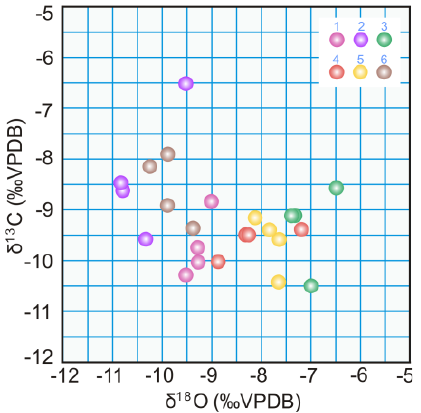
Figure 7. Comparison of stable isotope data in this study with other deposits in Dinaric Karst. 1 − Gostilje River Basin; 2 − Sopotnica River Basin; 3 − Zrmanja River Basin; 4 − Krka River Basin; 5 − Krupa River Basin; 6 − Plitvice Lakes.